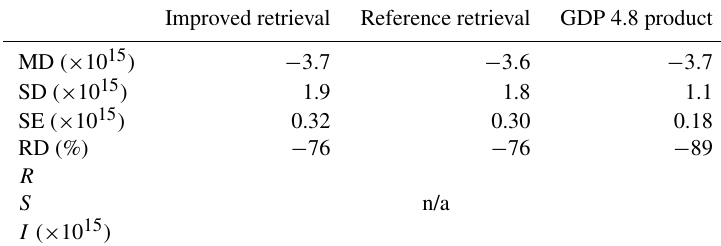
Table B3. Similar to Table B1 but for the remote Bujumbura station for a total of 36 monthly points. n/a – not applicable.